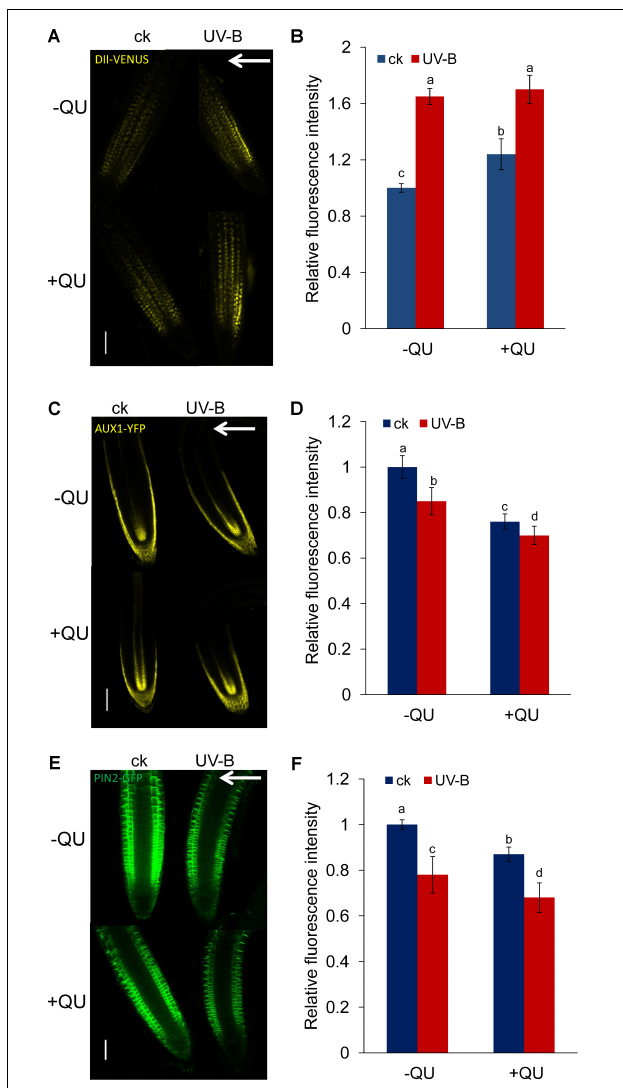
FIGURE 7 | UV-B radiation influences auxin accumulation and transport via flavonoids. GFP/YFP fluorescence in the roots of 5-d-old DII-VENUS (A) , AUX1:YFP (C) , and PIN2:GFP (E) seedlings exposed to 1.6 W m − 2 UV-B radiation for 1 h and then transferred to normal growth conditions plus 0 nM QU or 100 nM QU for 4 h. Quantification of DII-VENUS (B) , AUX1:YFP (D) , and PIN2:GFP (F) fluorescence intensities in the root tips is presented. Bars, 50 µ m. White arrows indicate the direction of UV-B-radiation; ck, before UV-B radiation control. The error bars represent the SE, and different letters indicate significantly different values ( P < 0.05 by Tukey’s